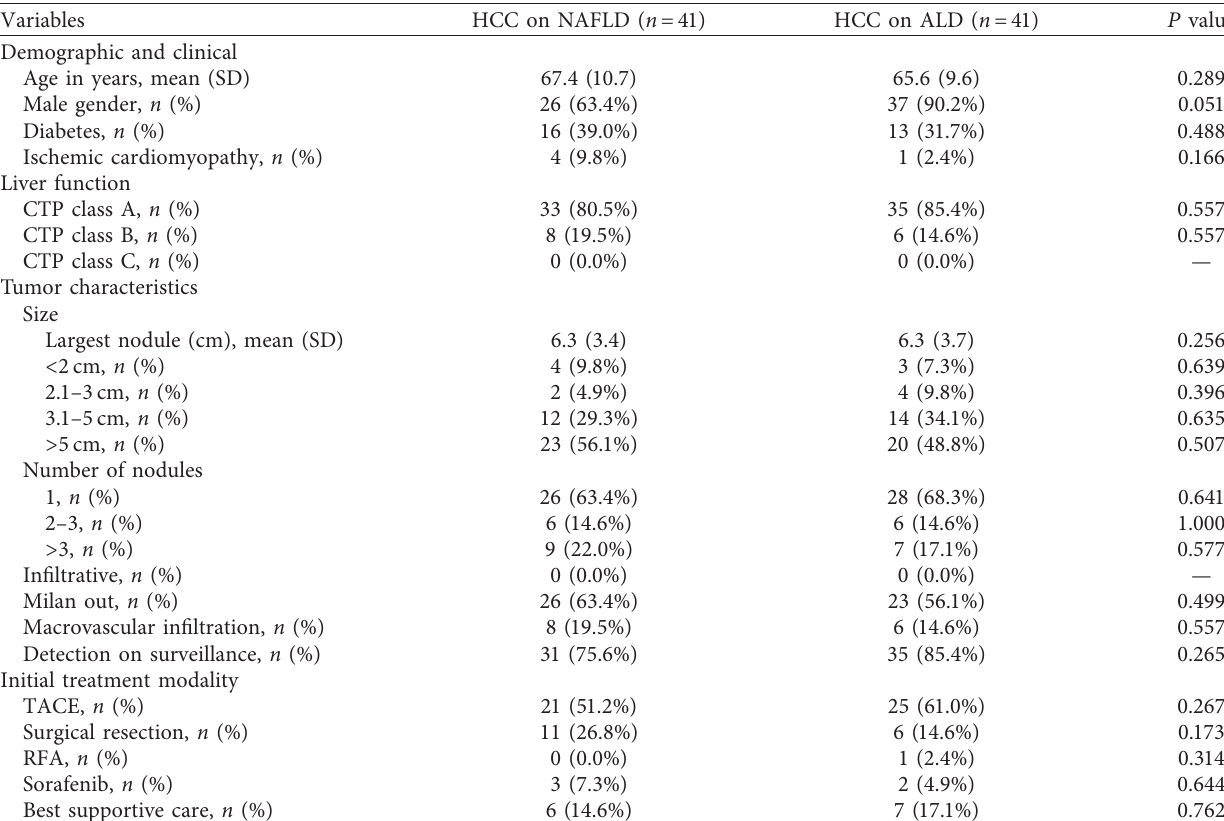
Table 4: Baseline characteristics of NAFLD-related and ALD-related HCC patients after a propensity score match analysis.